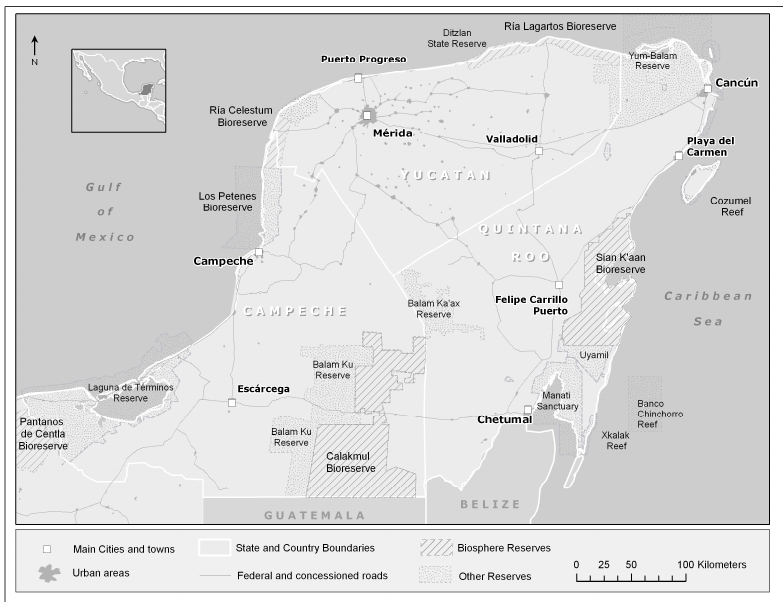
Figure 1. Study Area: Mexico’s Yucatán Peninsula. Major federal roads, main cities and towns, state boundaries, and protected areas.